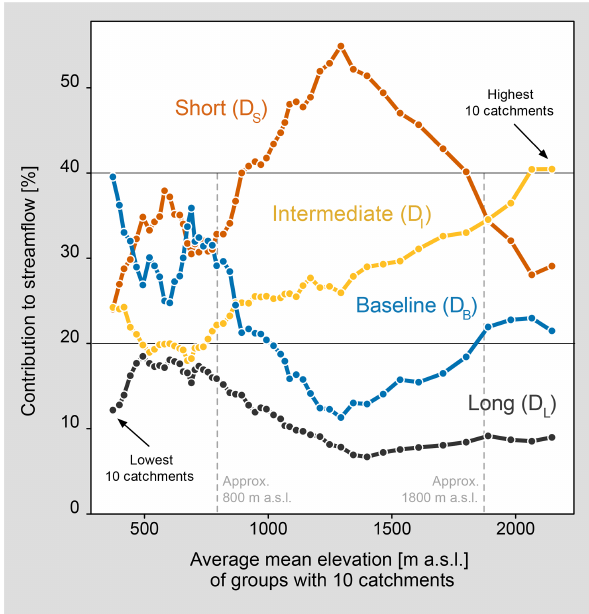
Figure 7. Relationship between elevation and contributions to streamflow in the different delay classes. Catchments are sorted ac- cording to mean elevation and grouped into sets of 10 catchments to estimate average mean elevation for each